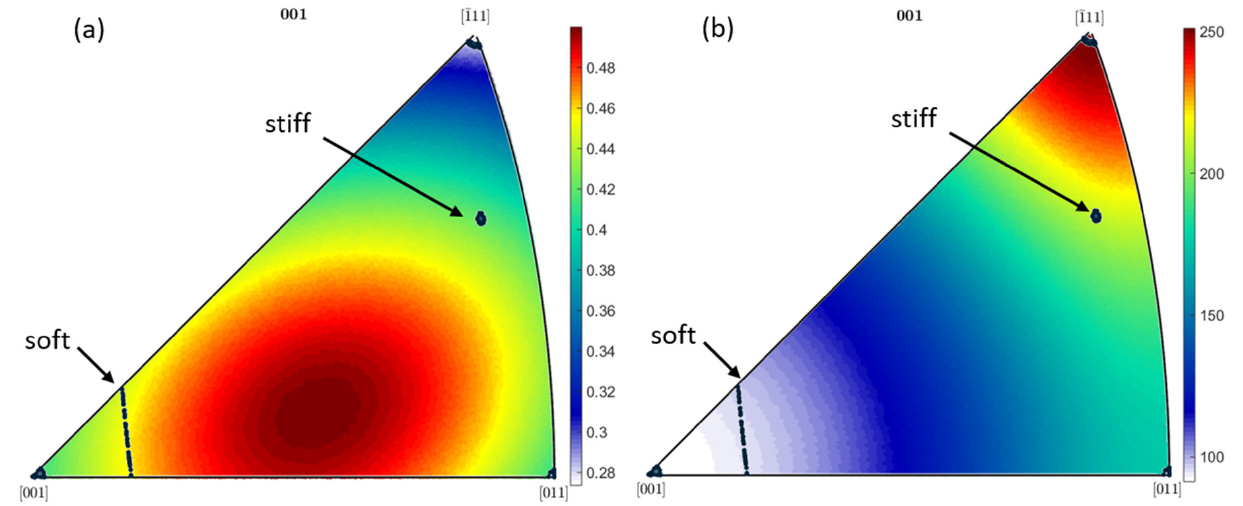
Figure 10. Inverse pole plot of the Schmid factor ( a ), inverse pole plot of the Young’s moduli of IN-738 LC at 850 °C ( b ) and the chosen orientation distributions.